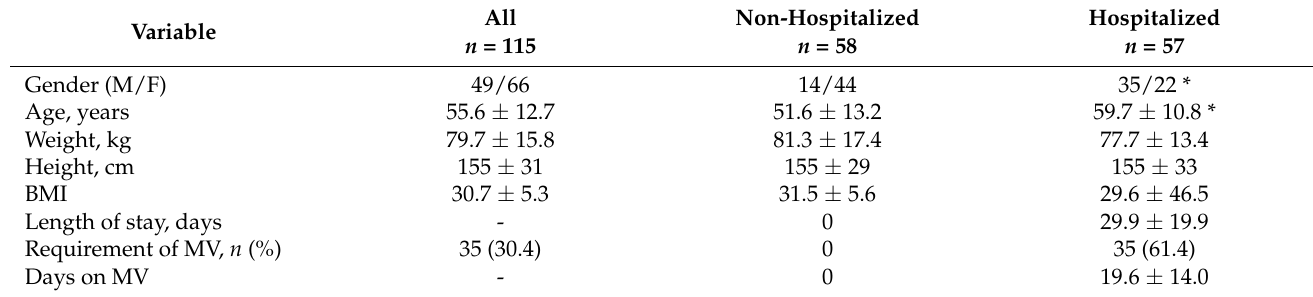
Figure 1. Flowchart of the selection process. Table 1. Patients’